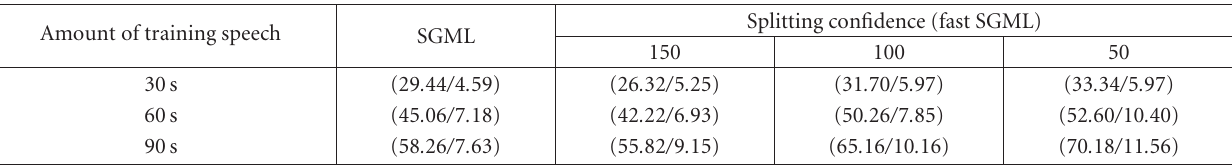
Table 2: The mean and standard deviation of the component number of the diagonal covariance female speaker GMMs obtained by the SGML and fast SGML on various amounts of training data. The first number in parentheses is the mean value while the second number after “/” is the standard deviation.